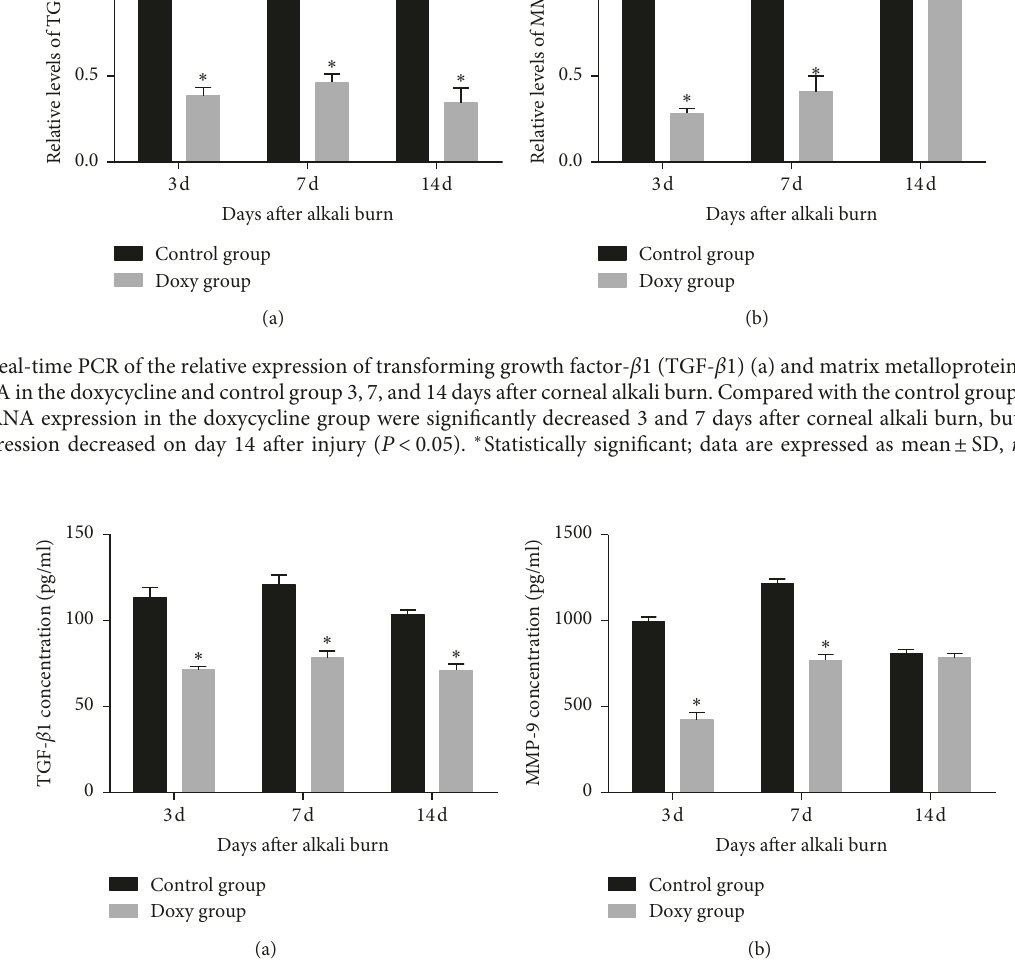
Figure 4: Transforming growth factor- β 1 (TGF- β 1) (a) and matrix metalloproteinase-9 (MMP-9) (b) concentrations in the doxycycline group and control group 3, 7, and 14 after corneal alkali burn. The doxycycline group showed a significant decrease in the TGF- β 1 and MMP-9 concentrations compared with control group on days 3 and 7 after injury, but just TGF- β 1 concentrations decreased on day 14 ( P < 0 . 05). ∗ Statistically significant; data are expressed as mean ± SD, n �